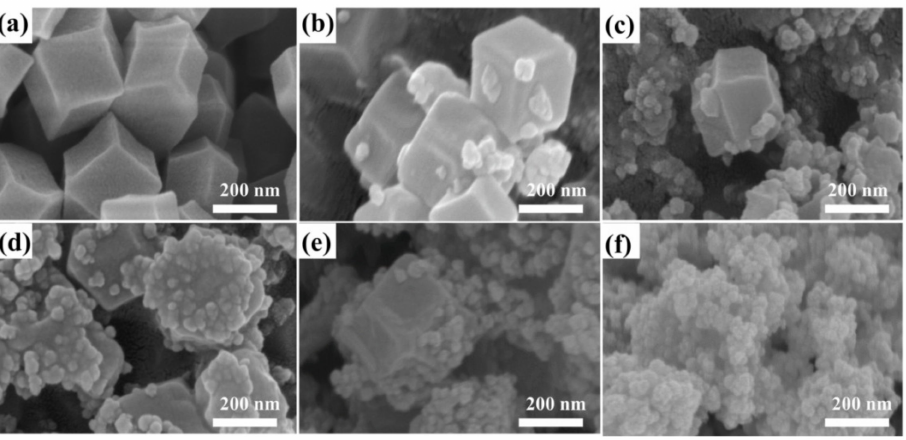
Figure 2. SEM images of ( a ) ZIF-8 and ( b – f ) ZIF-8@TiO 2 composites: ( b ) Z200T100, ( c ) Z150T150, ( d ) Z100T200, ( e ) Z75T225, and ( f )